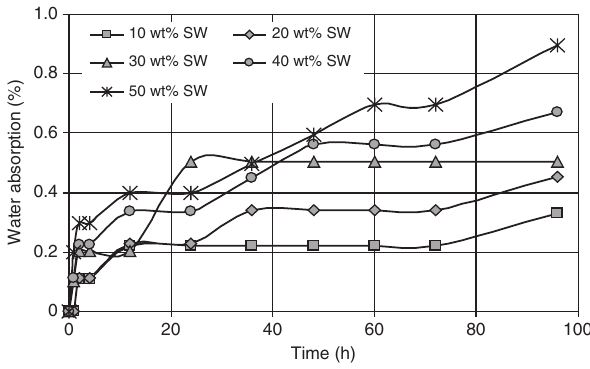
Figure 5 WA as a function of soaking time for different weight percentages of almond shell particles in SW.